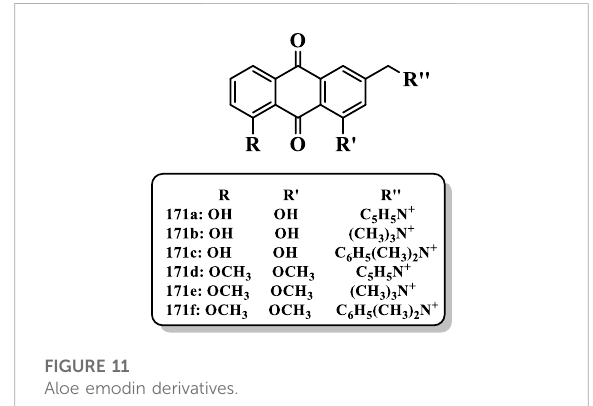
FIGURE 11 Aloe emodin